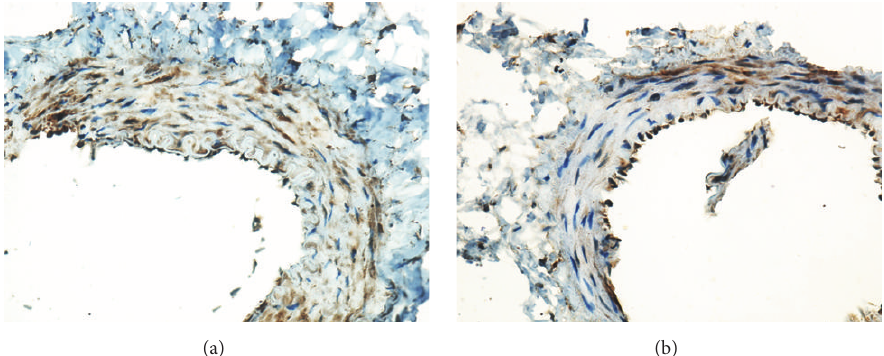
Figure 5: Immunohistochemical staining for MCP-1 in the graft vessels (original magnification × 400). (a) Surgical revascularization group: the expression of MCP-1 (brown staining of the granules) was obvious in the graft vessels wall. (b) Combined treatment group: the positive expression in the graft vessels was significantly decreased after islet